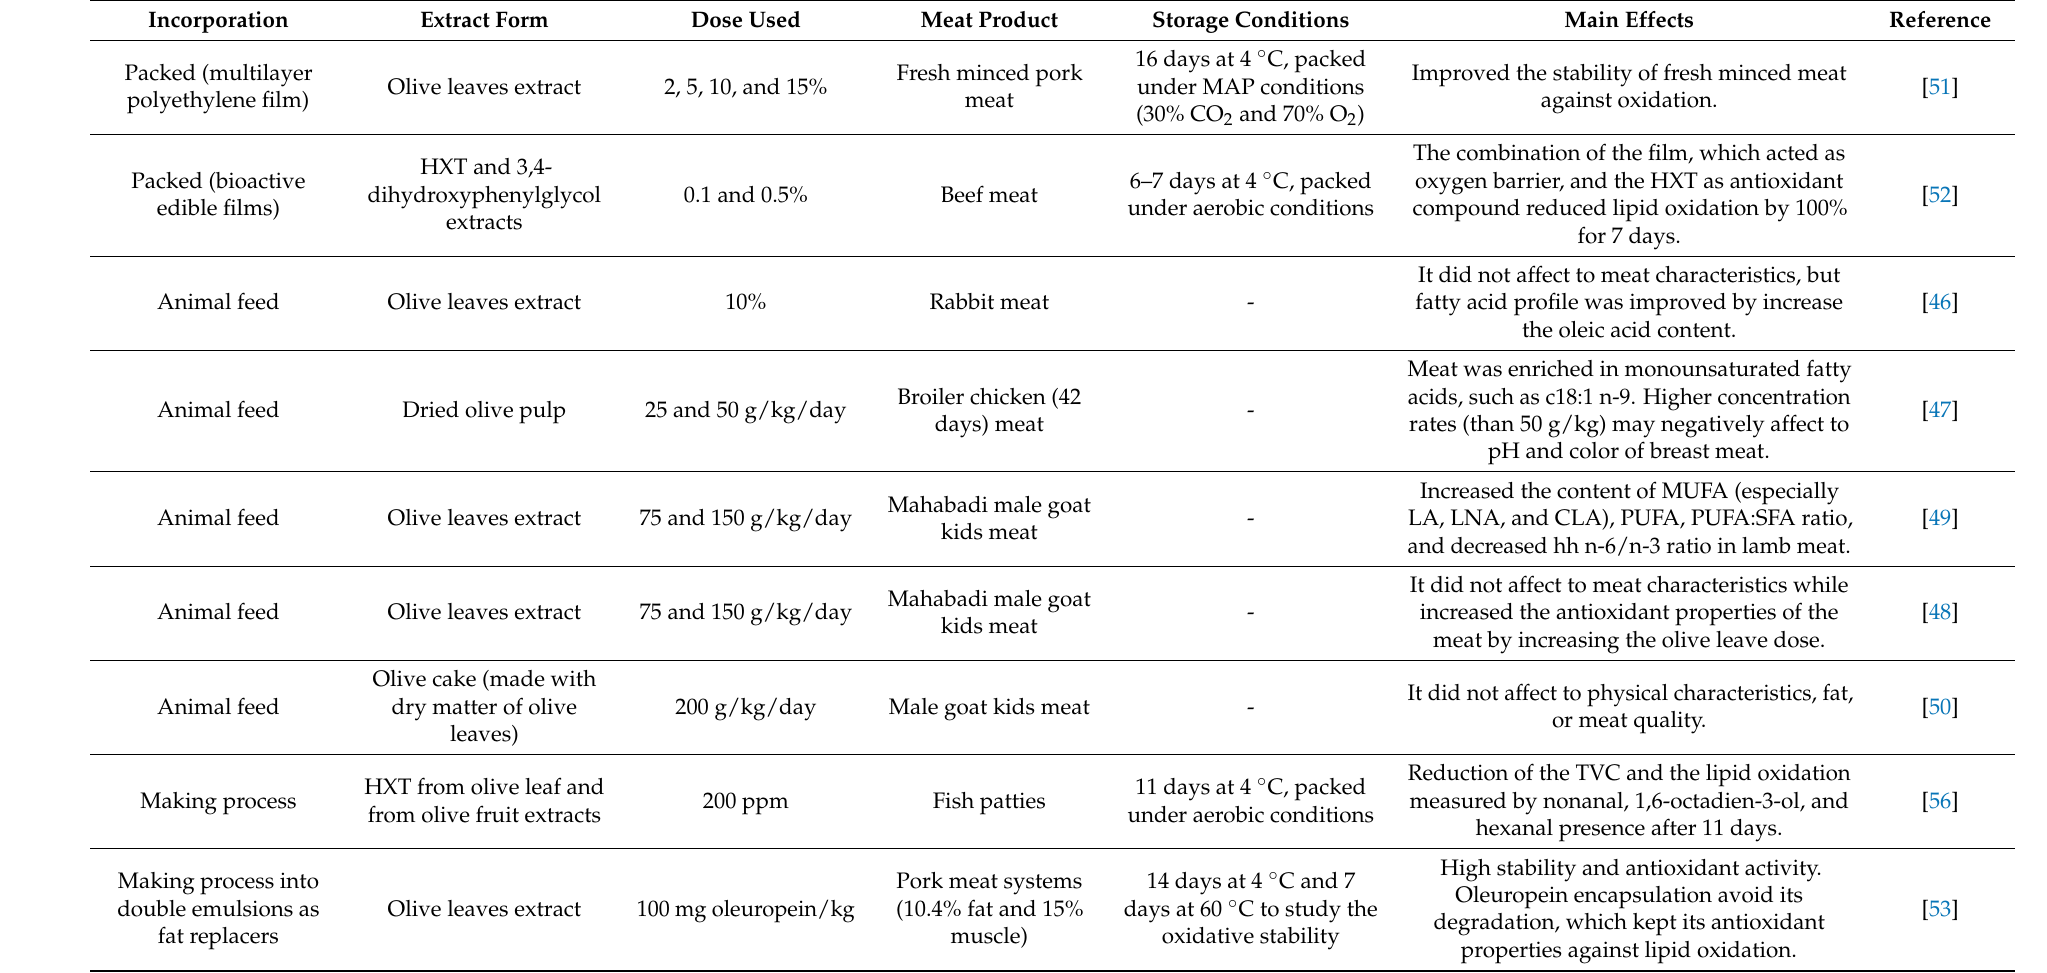
Table 2. Olive derivatives used as a preservative in meat